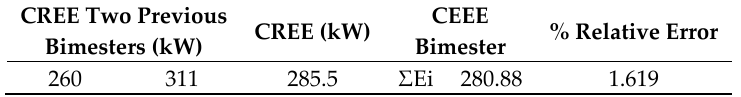
Table 1. Calculated bimonthly consumption compared to the recorded consumption.